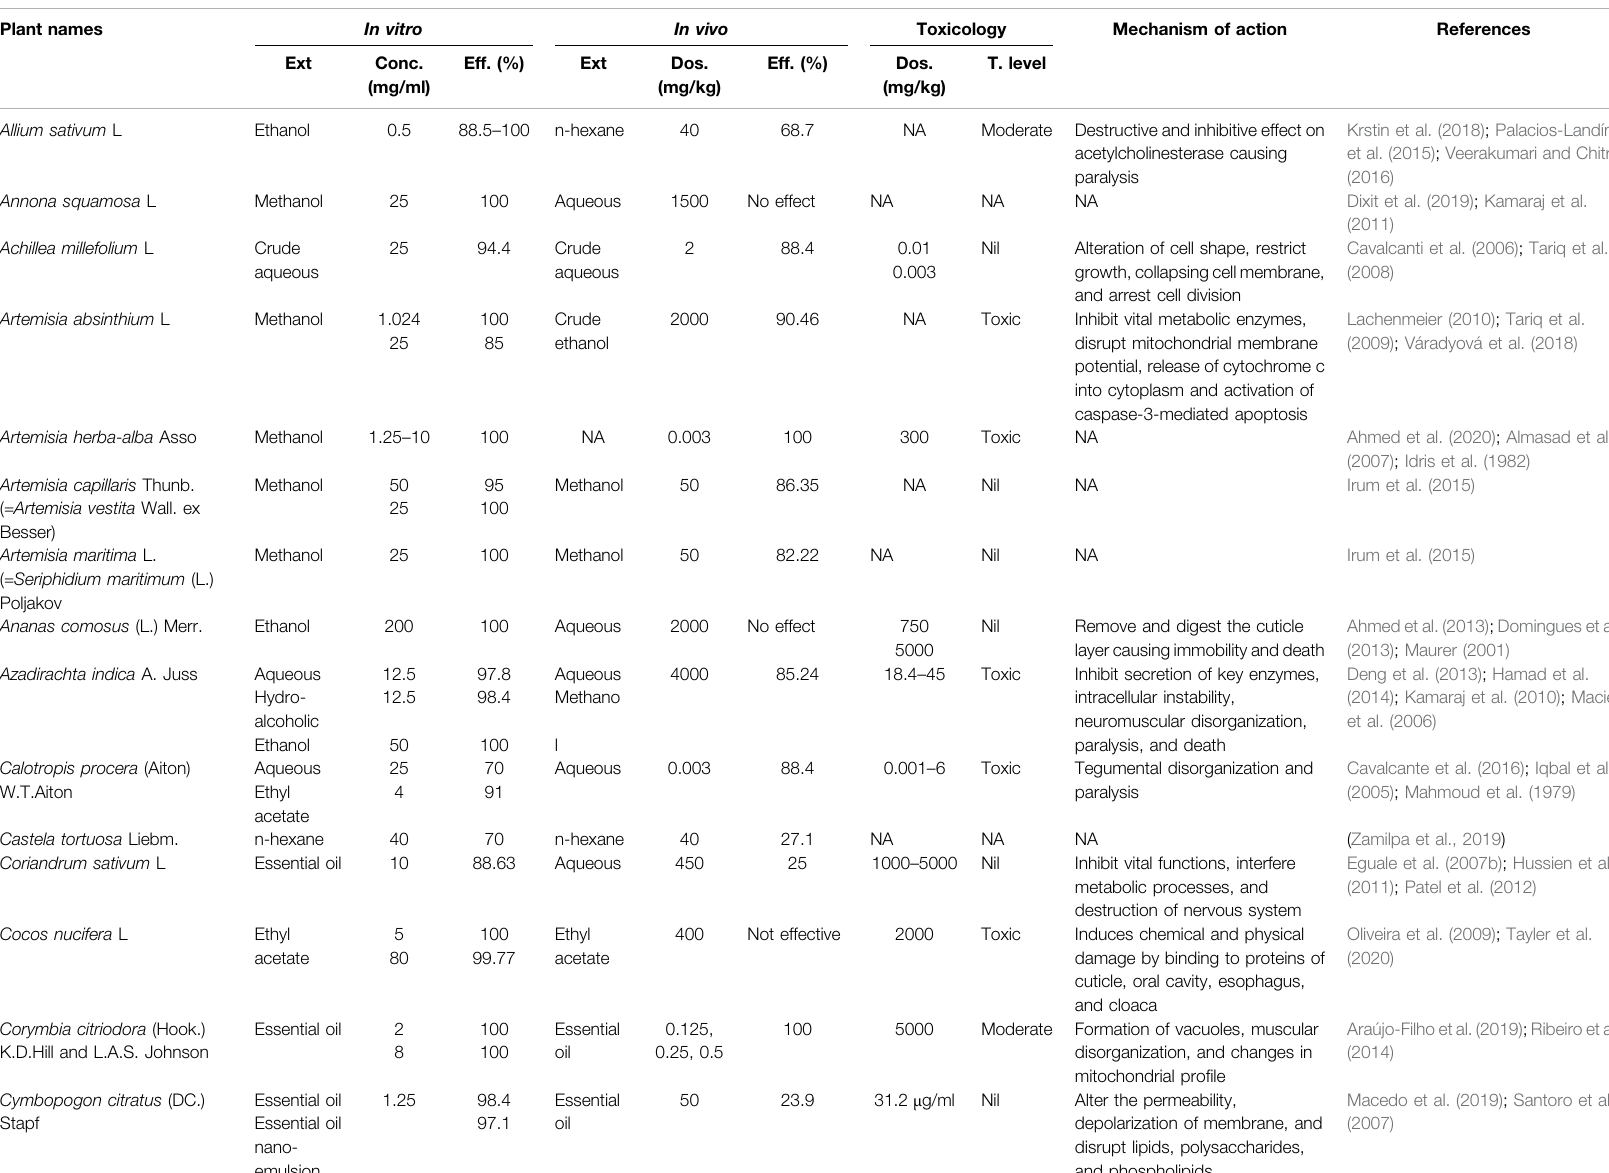
TABLE 2 | Comparative analysis, toxicology, and mechanism of action of medicinal